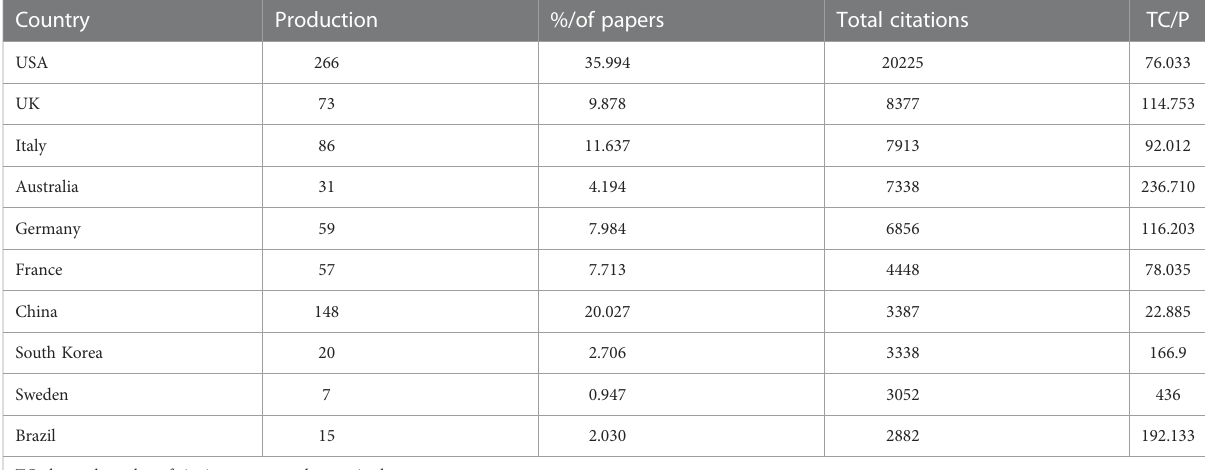
TABLE 1 Top 10 cited countries contributing to this research